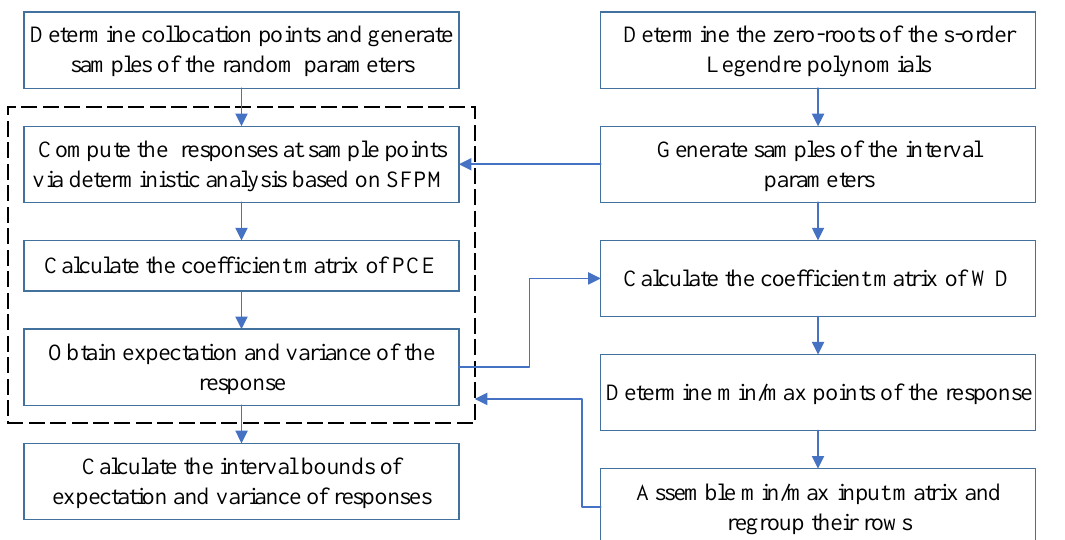
Figure 7. The flowchart of analysis, based on PCE-WD, for the defective nanobeam subject to random loads.